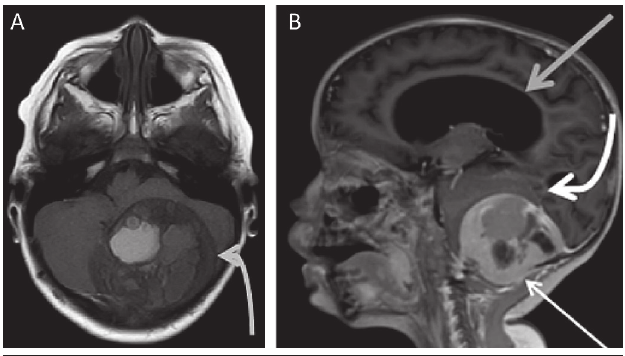
FigurE 2 − A) MRI in T1-weighted axial image without contrast demonstrating well- defined extra-axial mass in the posterior fossa (curved light gray arrow), projecting to the adjacent soft parts; B) MRI, T1-weighted post-contrast sagittal image demonstrating well- defined extra-axial mass in the posterior fossa traversing the posterolateral inferior occipital bone, projecting to the adjacent soft parts, with intense peripheral enhancement by contrast (fine white arrow), striking the cerebellar hemispheres (curved arrow) and distorting the fourth ventricle with severe hydrocephalus upstream (gray arrow) MRI: magnetic resonance